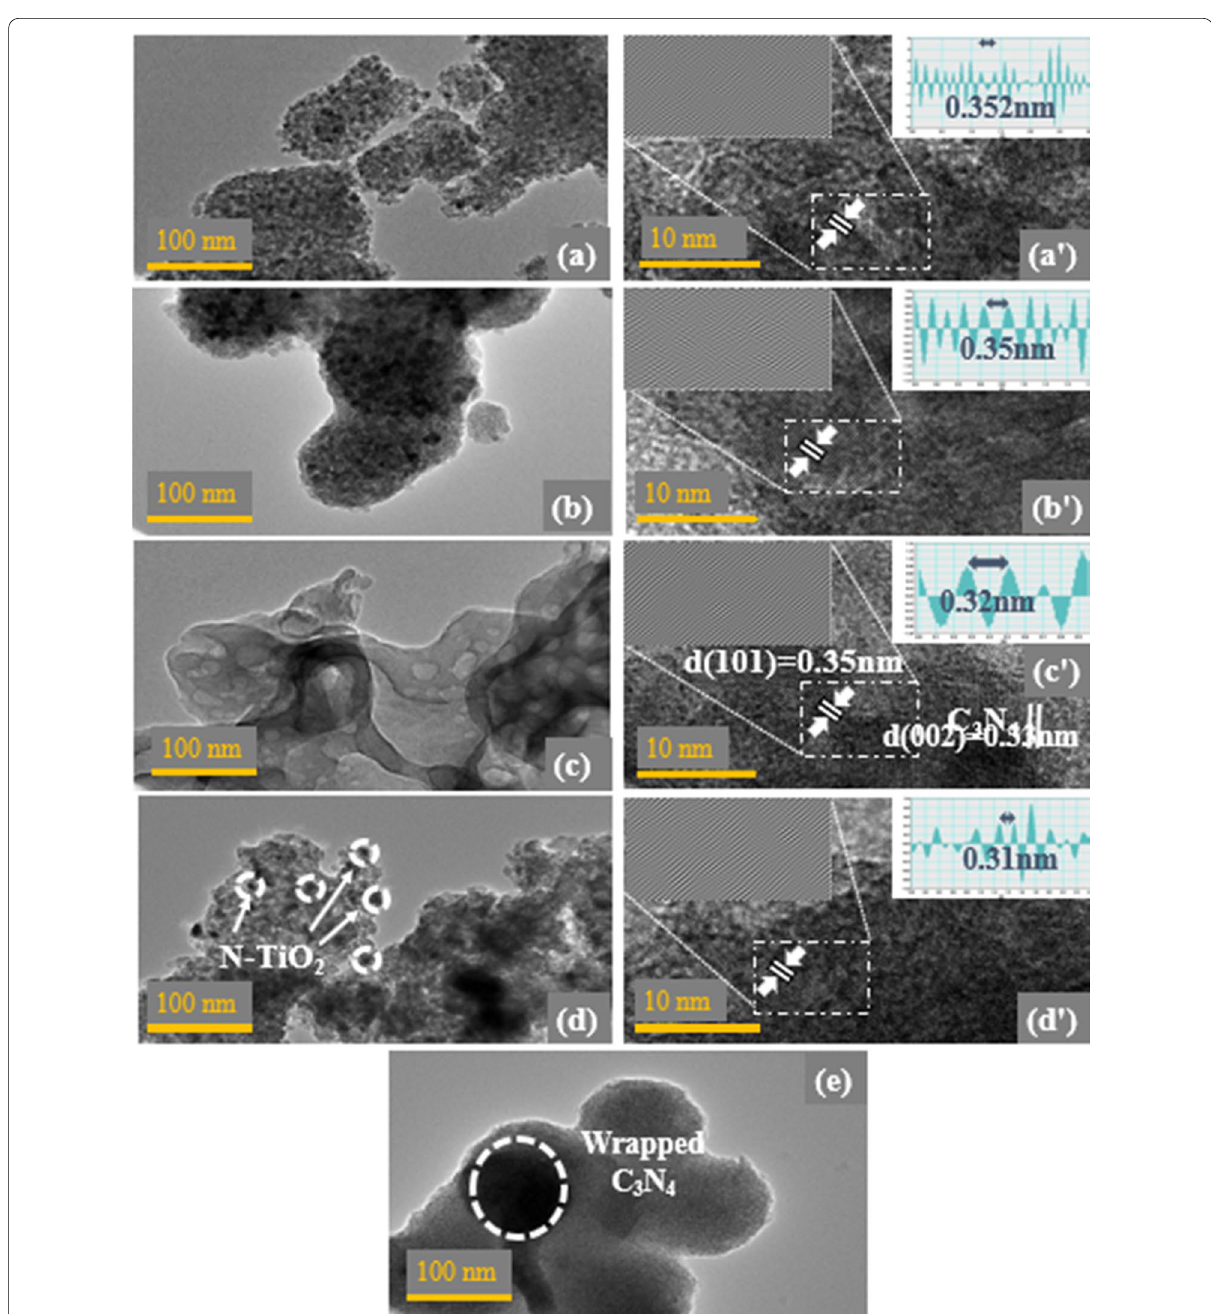
Fig. 3 a – e HR‑TEM micrographs of pristine TiO 2 , 0:1, 1:0, 0.1:1, 0.3:1, respectively. a ′ – d ′ Interlayer spacing measured using HR‑TEM images of pristine TiO 2 , 0:1, 0.1:1, 0.3:1,